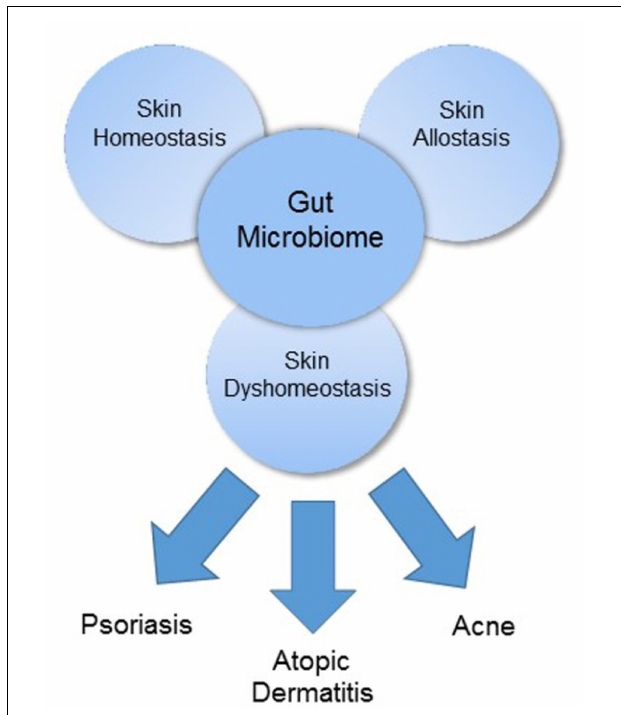
FIGURE 1 | The gut microbiome as a major regulator of the gut-skin